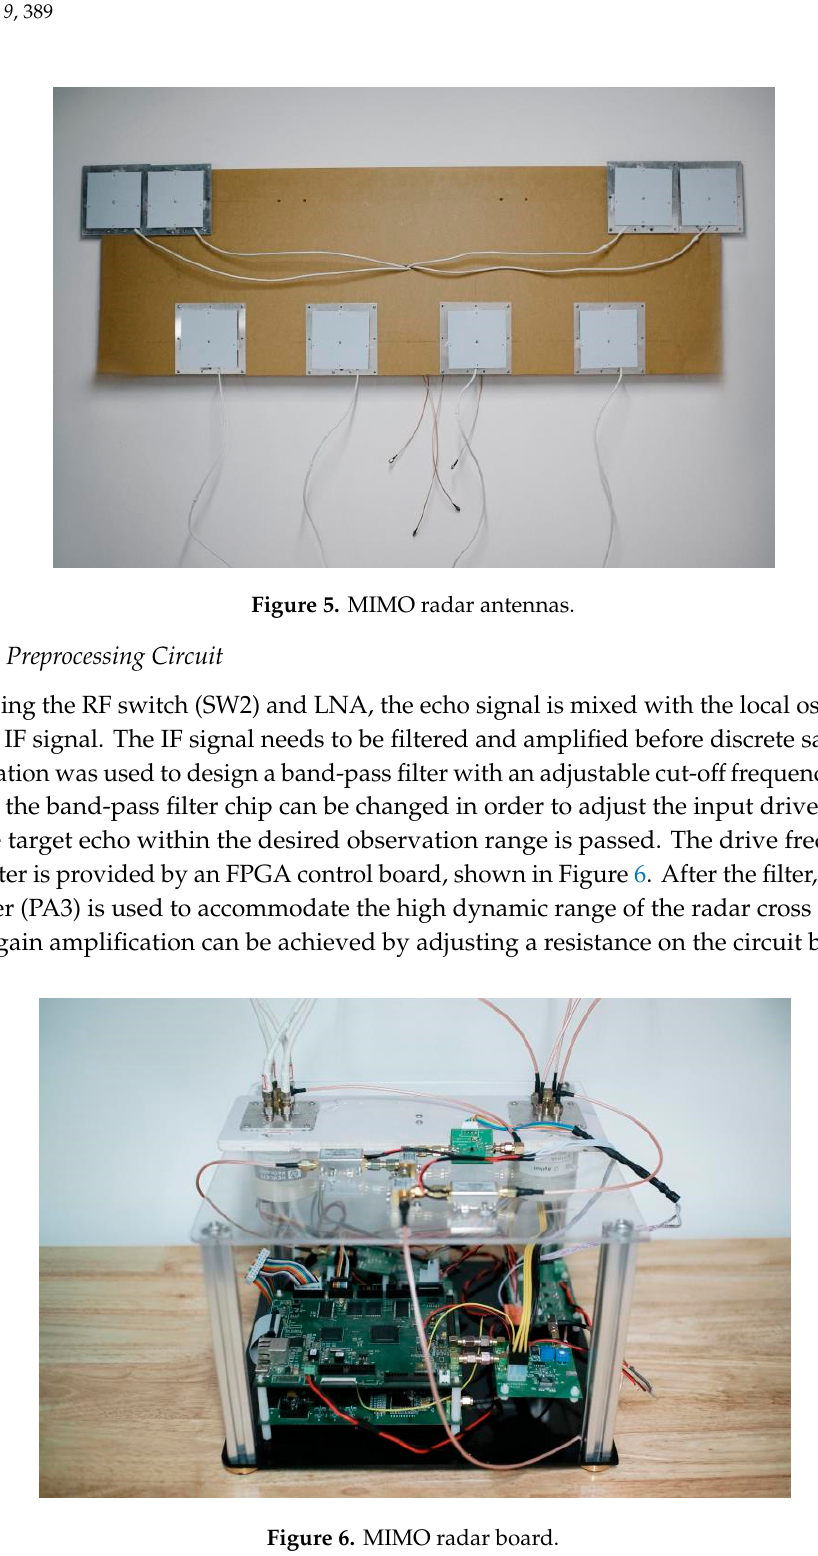
Figure 6. MIMO radar board.